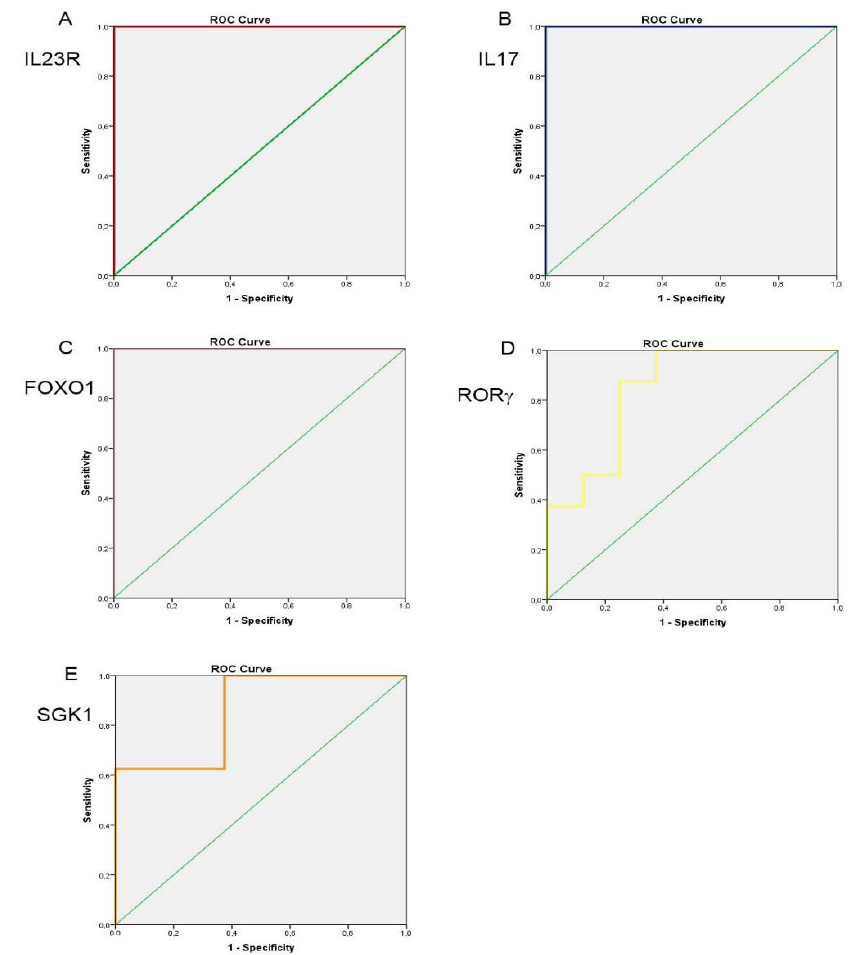
Figure 4. ROC curves for target genes expression levels used to evaluate the discrimination of patients with CVD from healthy controls. AUC of IL23R = 1 ( A ); AUC of IL17A = 1 ( B ); AUC of FOXO1 = 1 ( C ); AUC of RORG = 0.84 ( D ); AUC of SGK1 = 0.86 ( E ). AUC = 0.5 not informative test; 0.5 < AUC ≤ 0.7 not accurate test; 0.7 < AUC ≤ 0.9 moderately accurate test; 0.9 < AUC < 1 highly accurate test; AUC = 1 absolutely informative test. Table 3. Multivariable logistic regression analyses for the predictors of CVD.